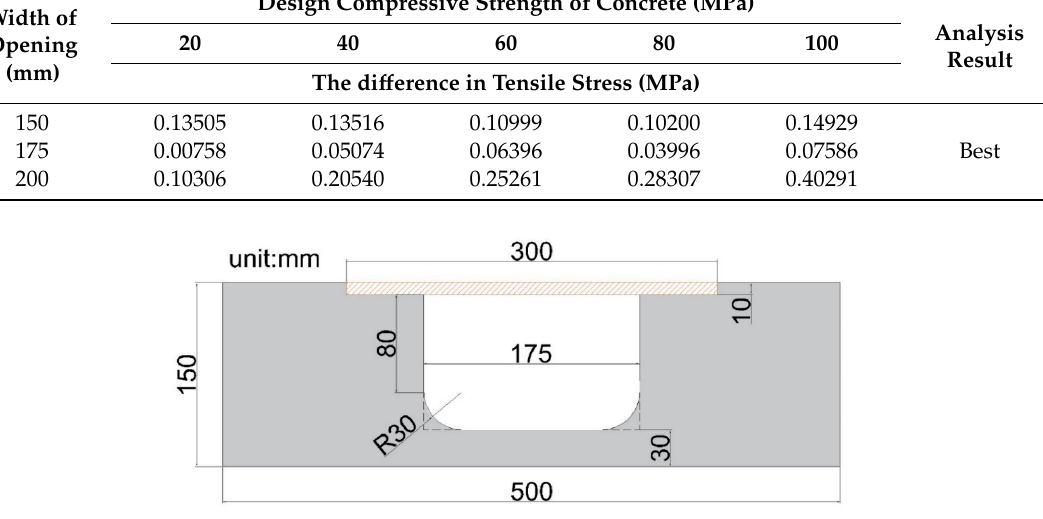
Figure 7. The geometry of designed strut-and-tie beam specimen.